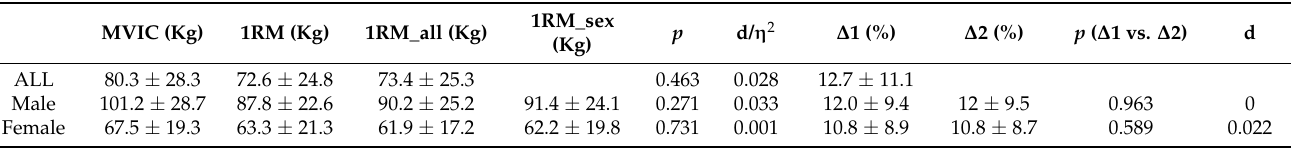
Table 6. MVIC and 1RM measured and estimated with two different regression functions in the testing